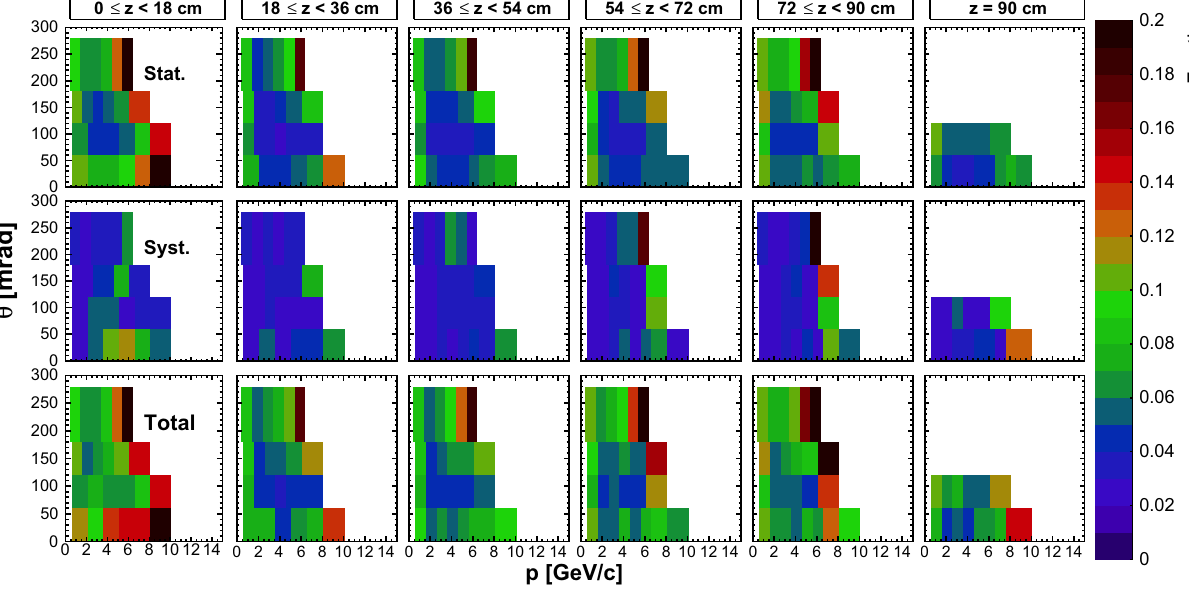
Fig. 19 Uncertainties on K + yields shown as a function of p and θ : statistical uncertainties (top row), total systematic uncertainties (middle row) and total uncertainties (bottom row). Each column corresponds to a different longitudinal